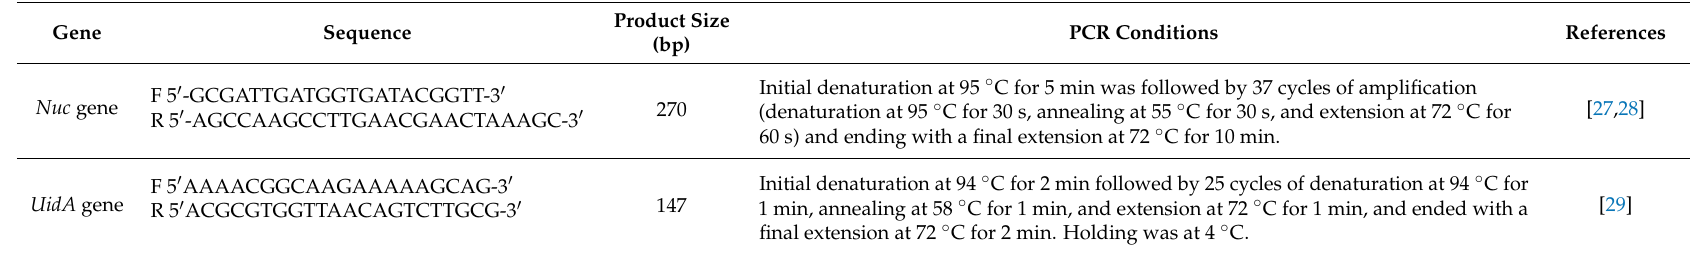
Table 1. Primers and PCR conditions for molecular identification of S. aureus.